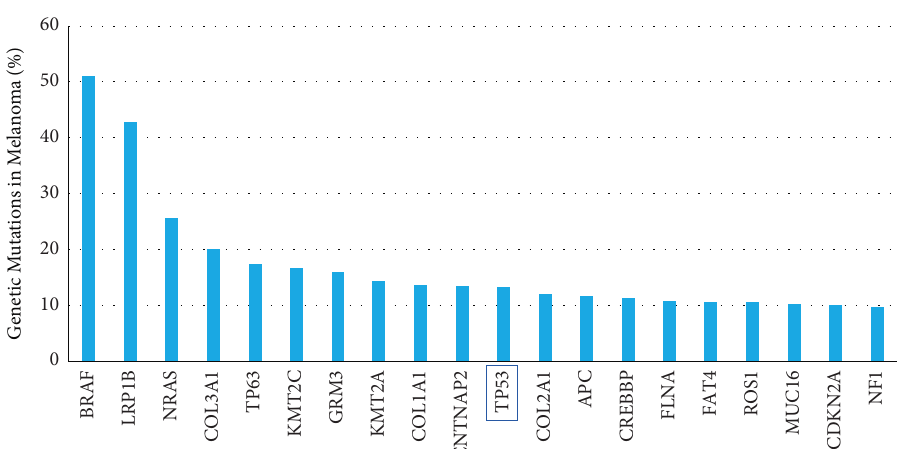
Figure 1: Most melanomas have an intact p53 gene. Tumors from 466 melanoma subjects in the United States were tested for simple somatic mutations as part of the TCGA study SKCM-US [17]. Genes were ranked by the frequency of mutation. Top 20 results are shown.